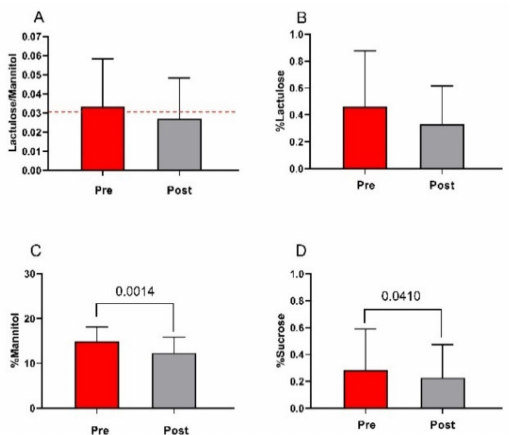
Figure 5. The small intestinal permeability (s-IP) before and after low FODMAPs diet. Panel ( A ) Lactulose to Mannitol ratio; panel ( B ) % lactulose; panel ( C ) % mannitol; panel ( D ) % sucrose. Data are presented as mean ± SD. Statistical analysis: Wilcoxon matched-pairs signed-rank test with a significant difference set at p < 0.05. The cutoff value is indicated by the red dashed